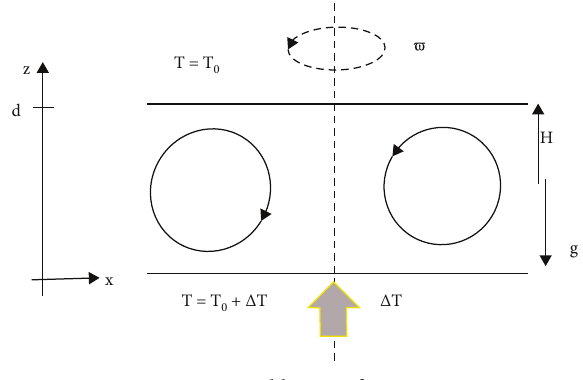
Figure 1: Problem